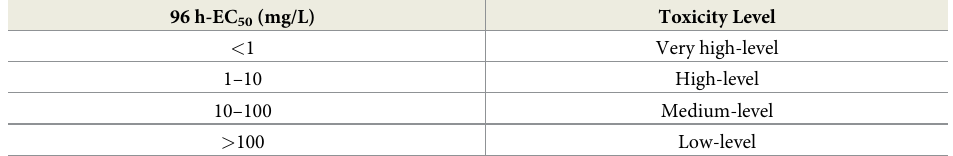
Table 1. Acute toxicity test classification criteria for